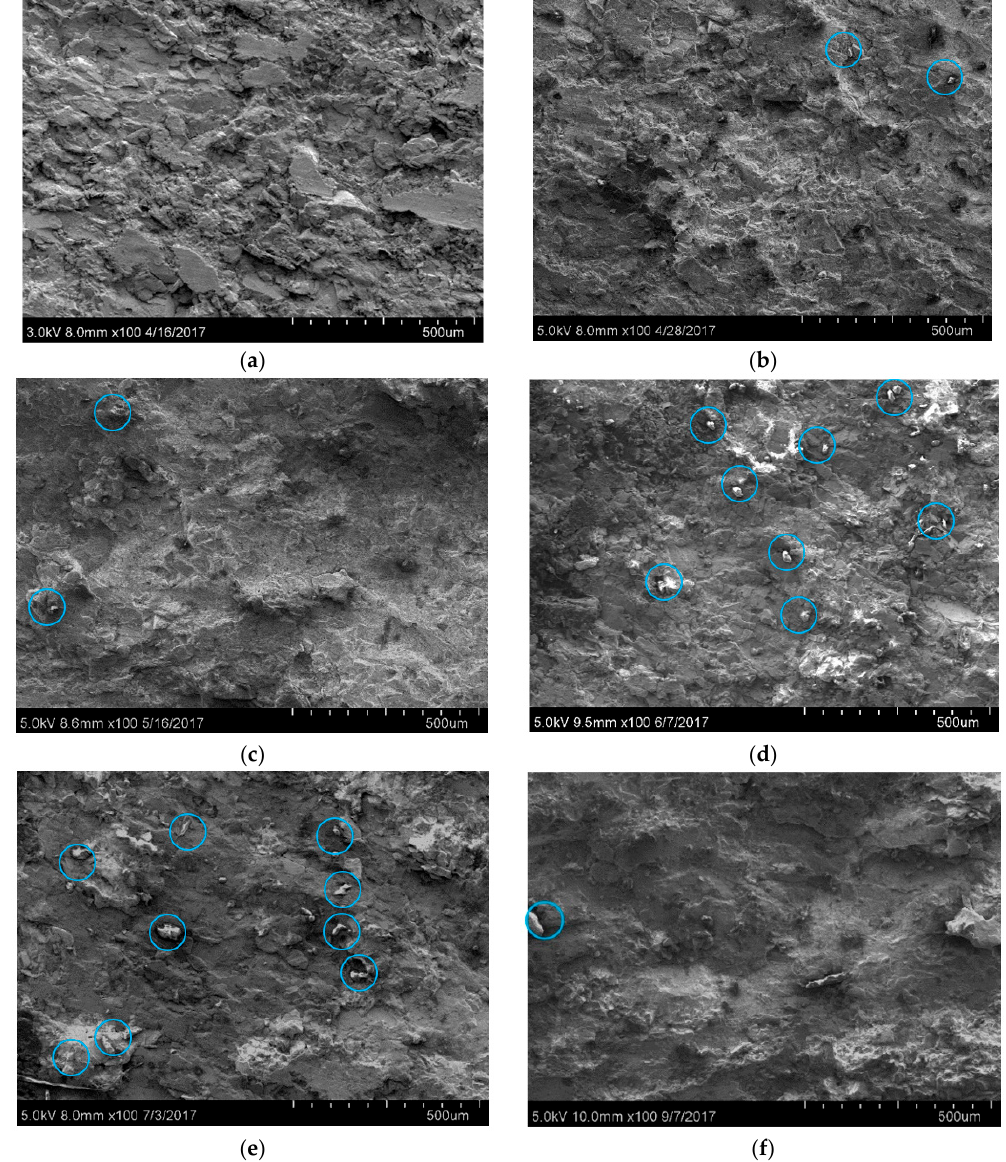
Figure 10. SEM images of rocks after different numbers of dry-wet cycles. ( a ) zero cycles; ( b ) one cycle; ( c ) three cycles; ( d ) six cycles; ( e ) ten cycles; and ( f ) fifteen cycles.